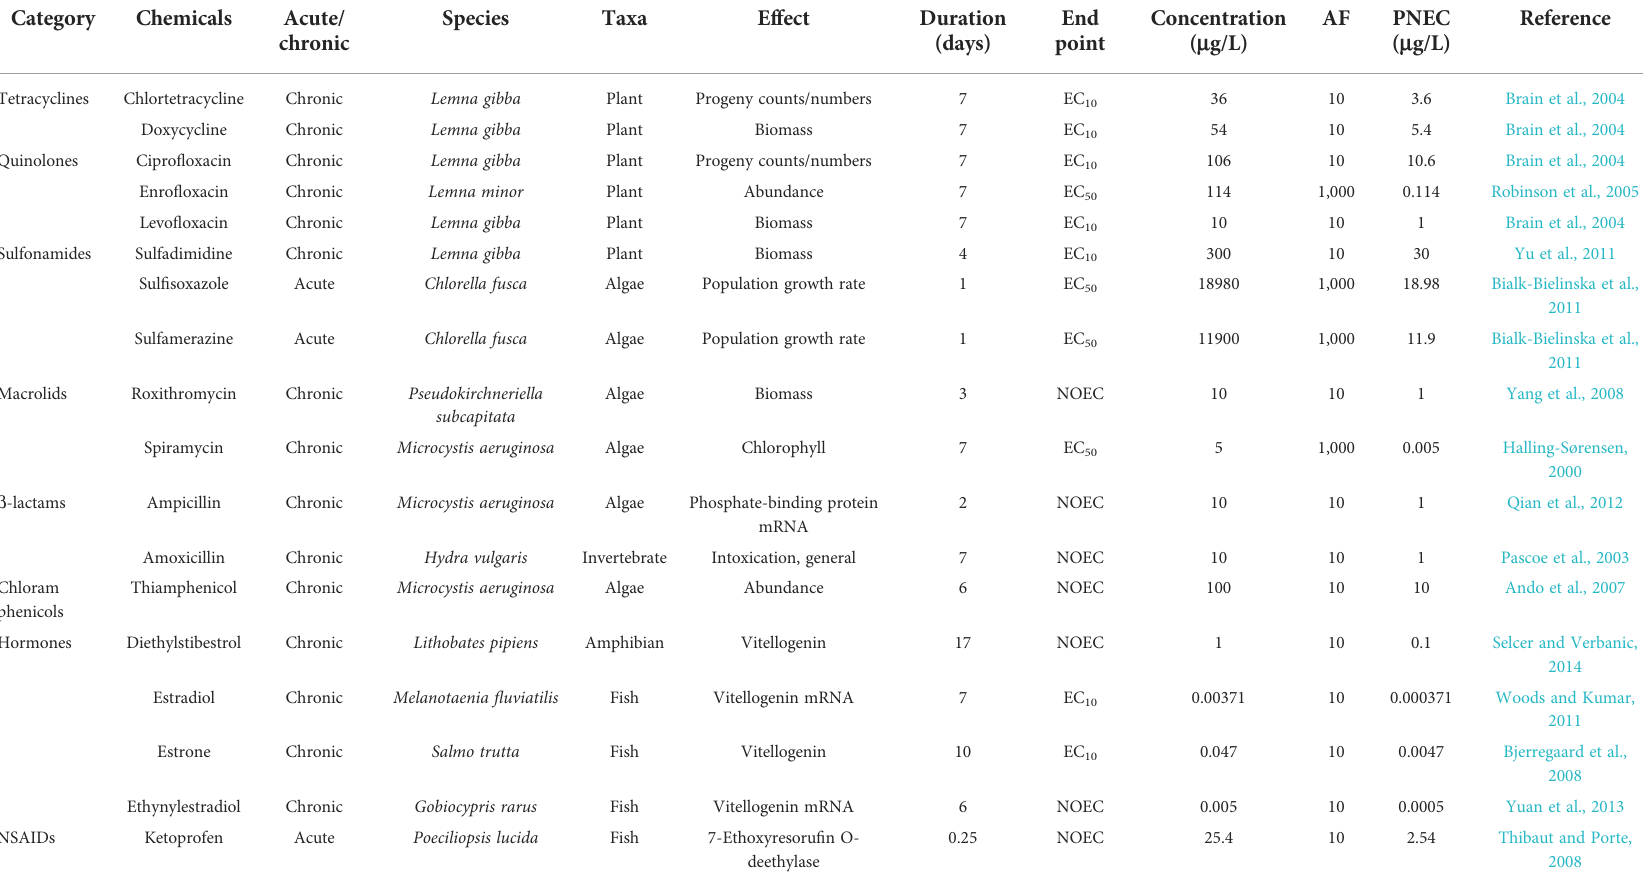
TABLE 2 Derived predicted no-effect concentrations (PNECs; in micrograms per liter) using the assessment factor (AF)